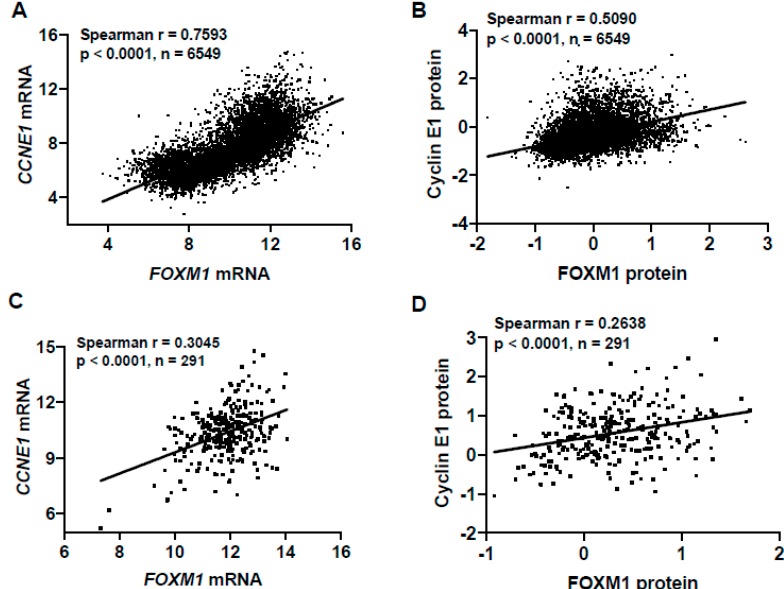
Figure 7. FOXM1 and CCNE1 expression correlation in pan-cancer and high-grade serous ovarian cancer (HGSC) tissues. ( A ) Correlation of FOXM1 expression and CCNE1 mRNA expression (RNA- seq RSEM, log2(norm count +1)) in TCGA pan-cancer tissues. ( B ) Correlation of FOXM1 expression